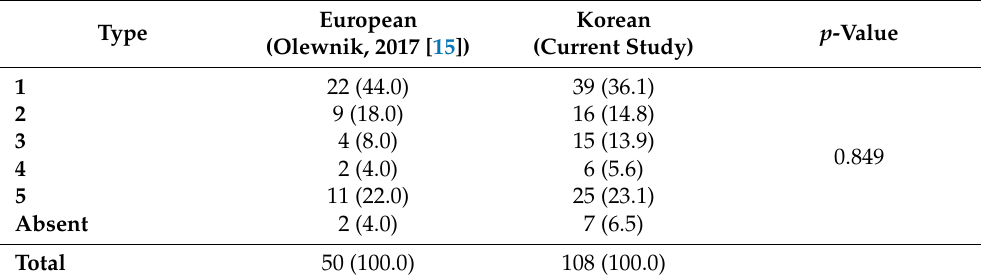
Table 3. Frequency analysis of Koreans and Europeans according to the type of plantaris